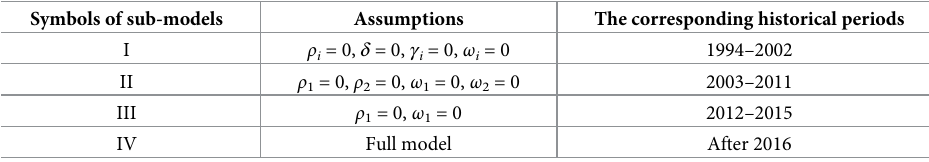
Note. i = 1,2,3, which represents infection stage in the full